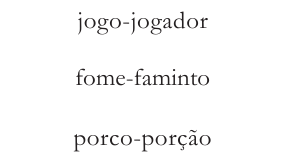
Figura 5. Exemplo de itens do teste de relacionamento morfológico.